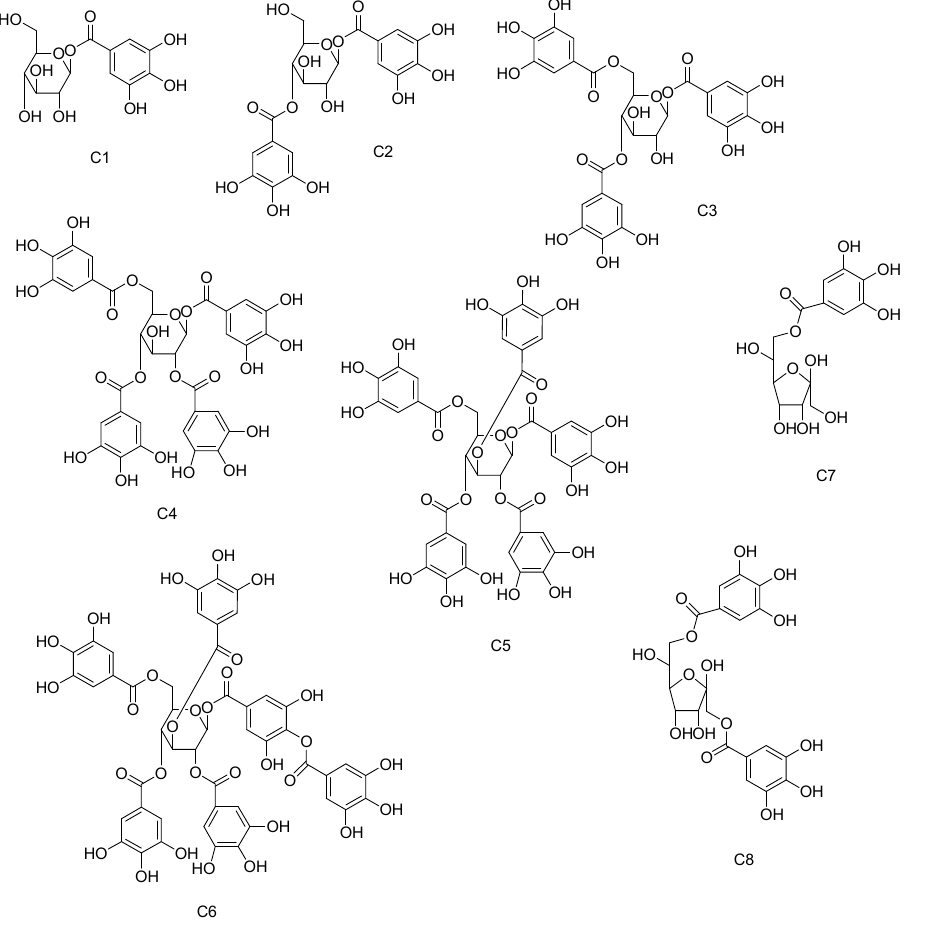
Figure 8. Examples of the structures of the tannin type of C1 – C8 .